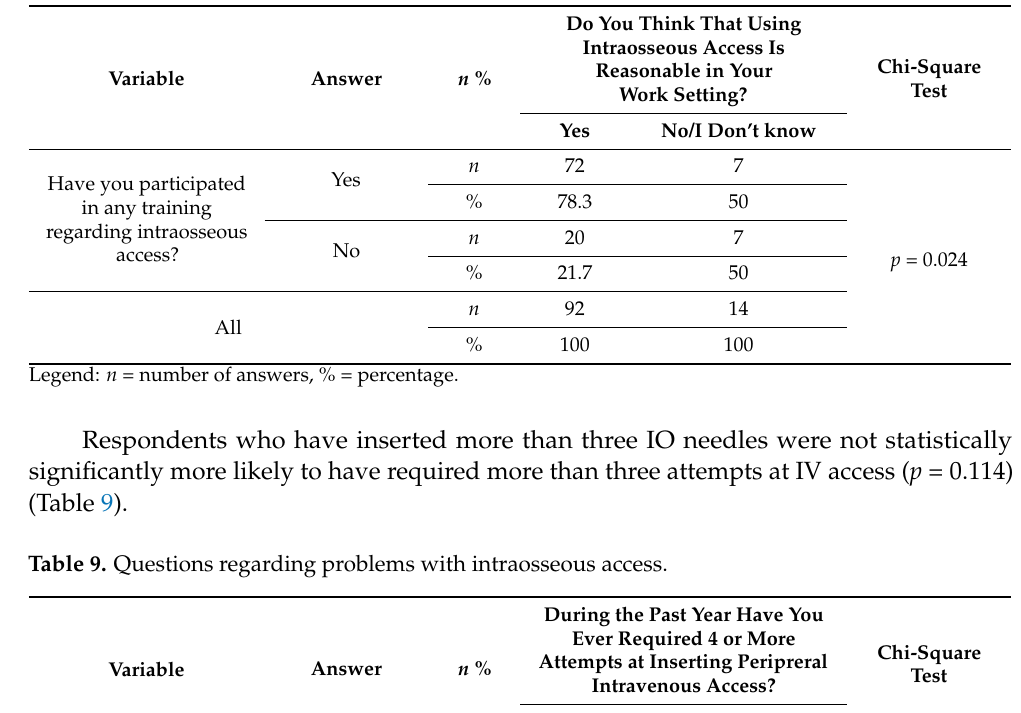
Table 8. Using intraosseous access makes sense vs. participation in any